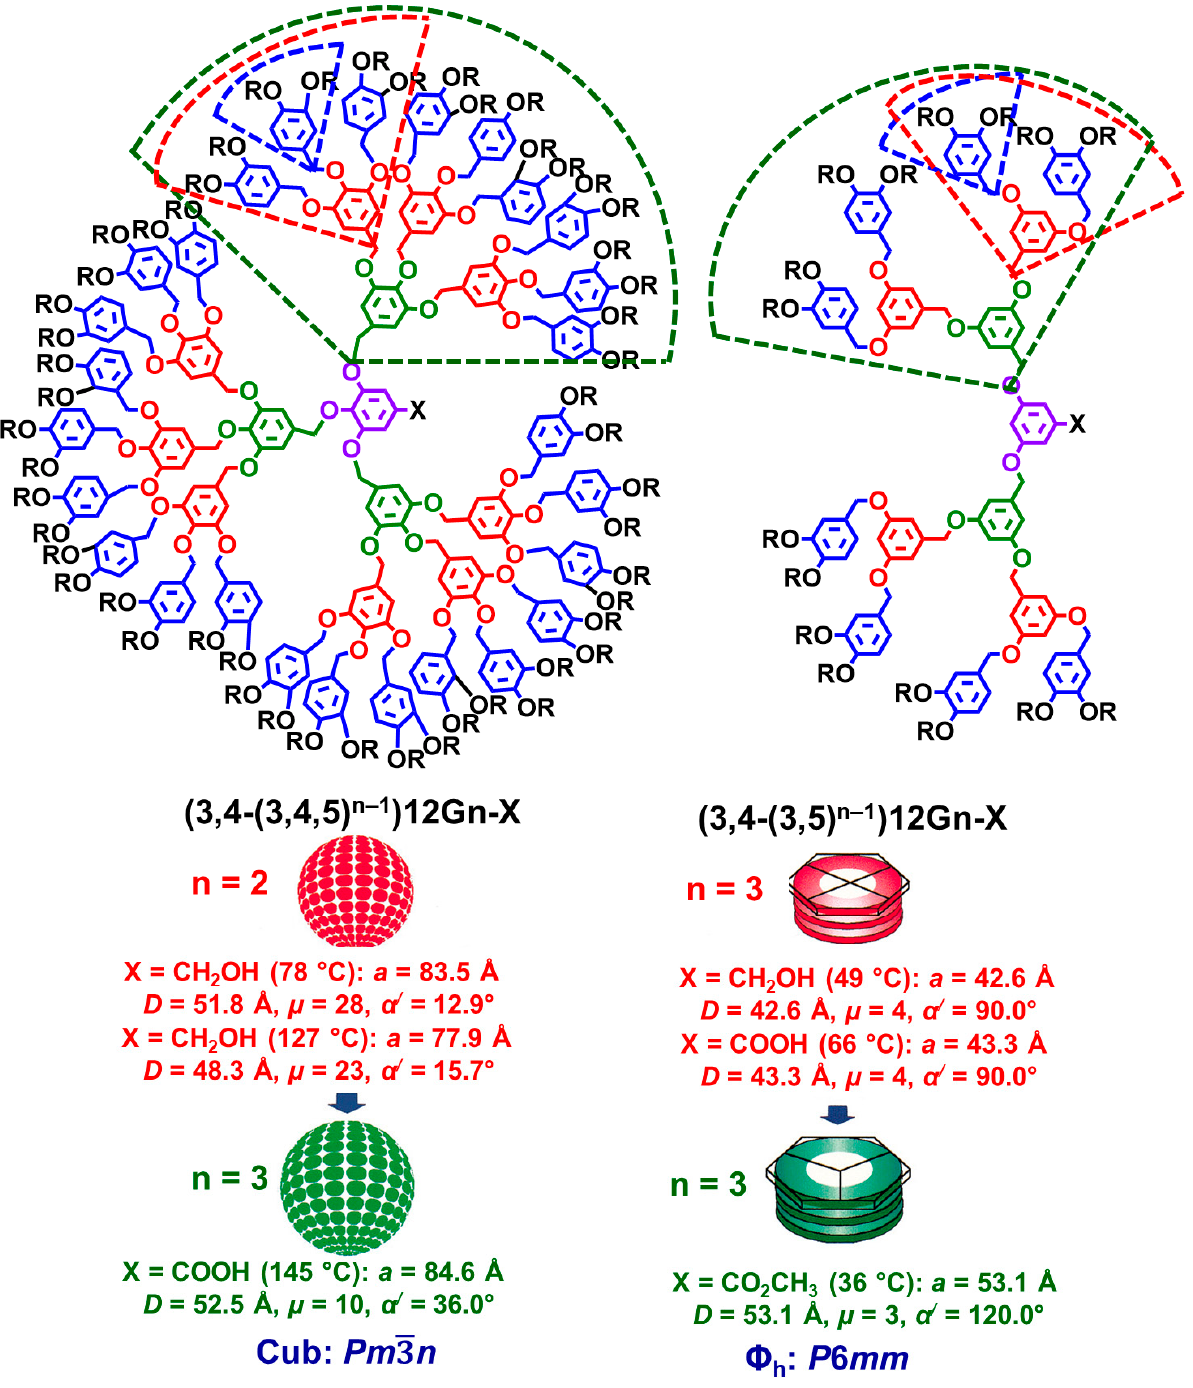
Figure 9. An example that demonstrates the role of the multiplicity of the branching point during the self-organization of a supramolecular assembly. Structural and retrostructural analysis of supramolecular dendrimers self-assembled from AB 3 3,4,5-trisubstituted monodendrons of generation 2 and 3 are shown on the left side and from a generation 3 AB 2 3,5-disubstituted dendron on the right side [126]. Parts of the Figure were adapted, combined, and modified from [126]. Copyright © 2004, American Chemical Society.